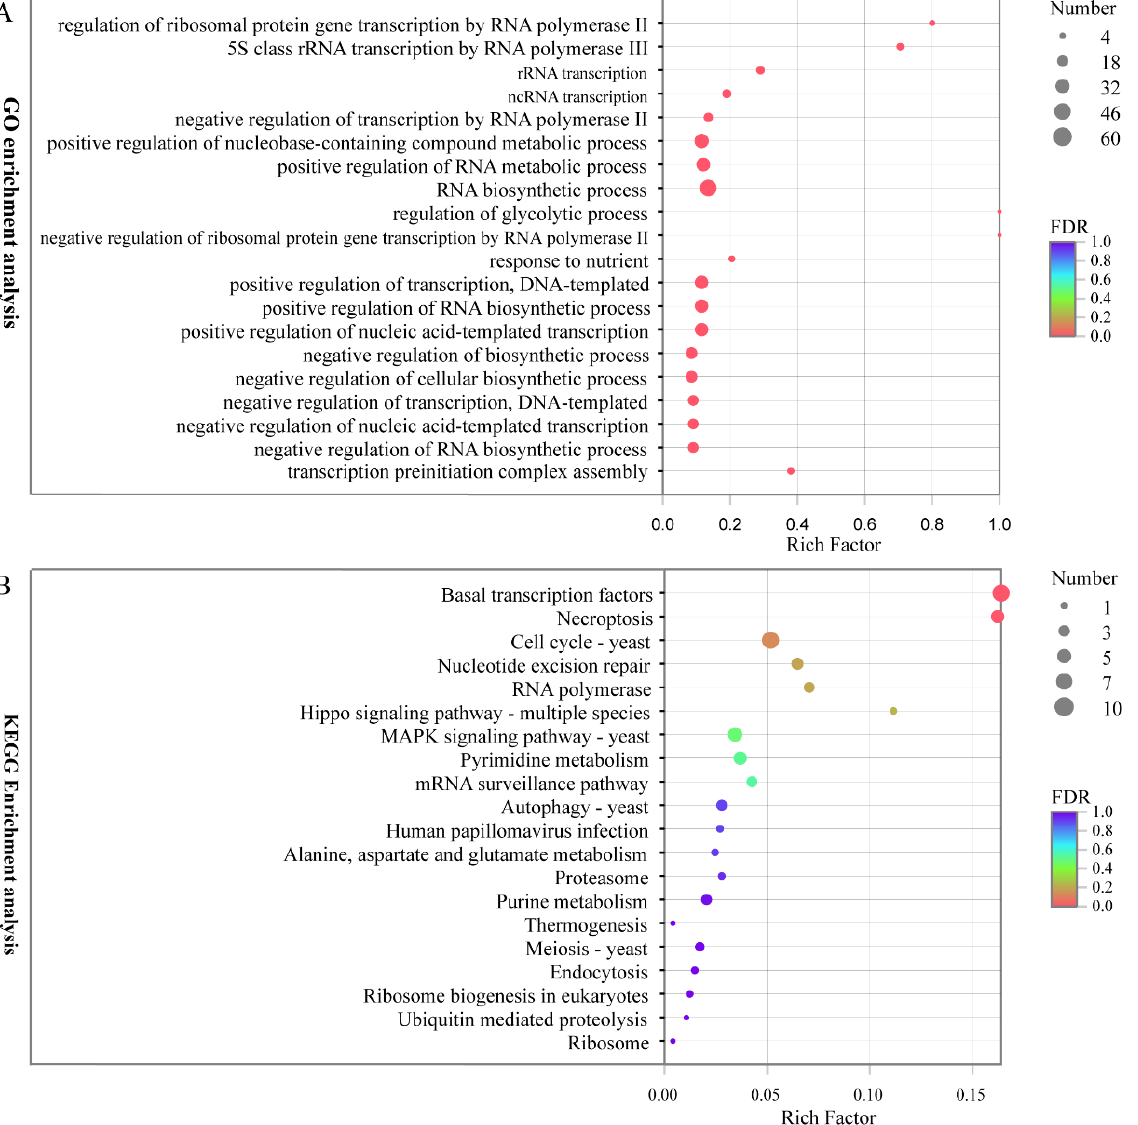
Figure 4. GO and KEGG enrichments of TFs. ( A ) GO enrichment analysis. ( B ) KEGG enrichment analysis. The x ‑axis shows the enrichment factor. Blue represents a high q value and red represents a low q